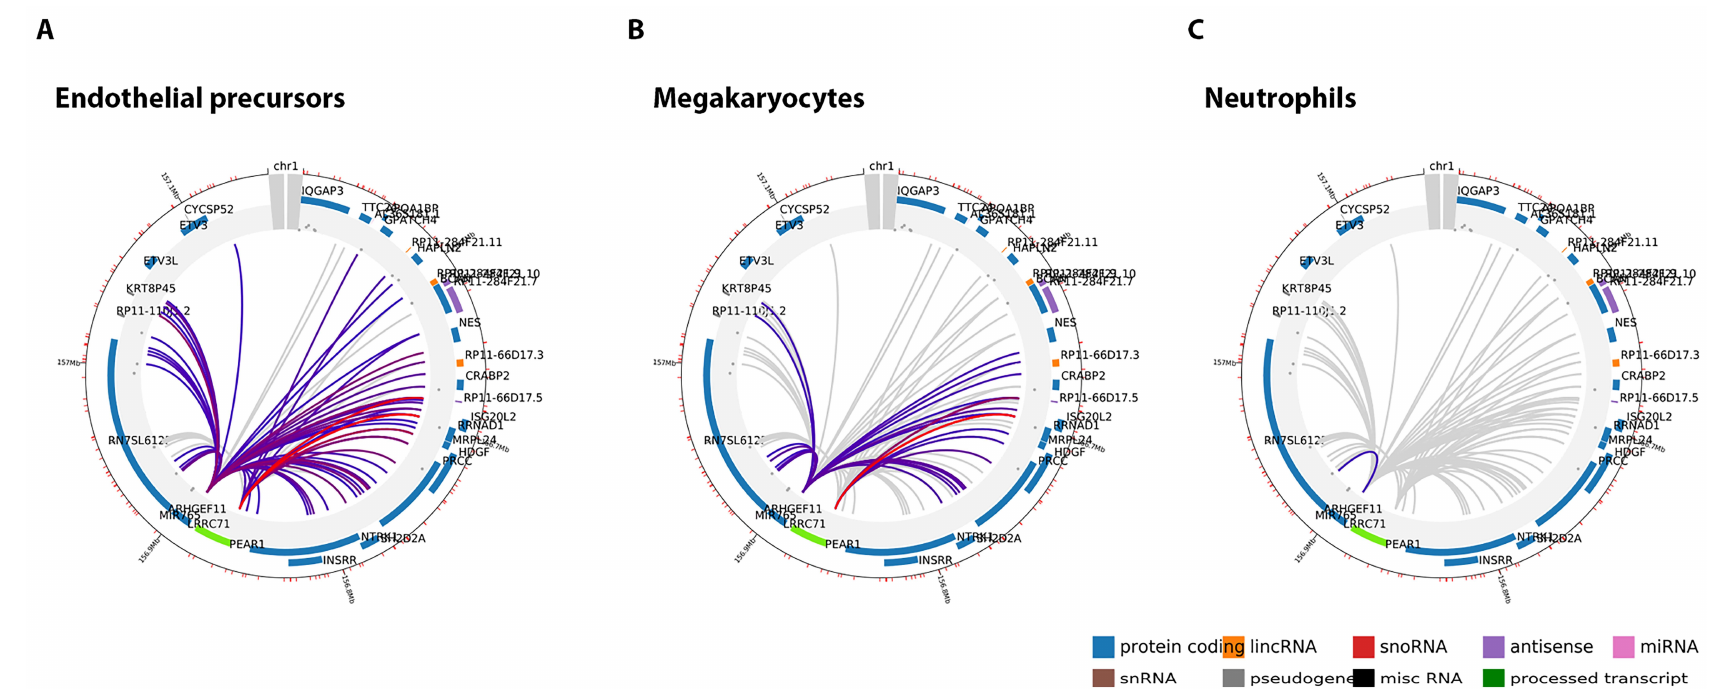
Figure 3. Endothelial precursors and megakaryocytes share similar PEAR1 interactome. Circular overview of PEAR1 interactions in endothelial precursors ( A ); megakaryocytes ( B ) and neutrophils ( C ). Two baits are found in PEAR1 to show interactions, one at the beginning (7.48 Kb, chr1:156,861,611–156,869,031, Assembly 2009, displayed as black box in Figure 1) and one towards the end of the gene (21.26 Kb, chr1:156,881,919–156,903,177, Assembly 2009). Interacting genes are connected by lines and their names are reported on the circle together with their genomic context, defined by colours (protein coding in blue, lincRNA in orange, snoRNA in red, antisense transcript in purple, miRNA in pink, snRNA in brown, pseudogene in grey, miscRNA in black, processed transcripts in green). Interactions with score above 5 are represented with coloured lines with red being the colour referring to the top interactions. Grey lines represent interactions with score below 5, discarded from the